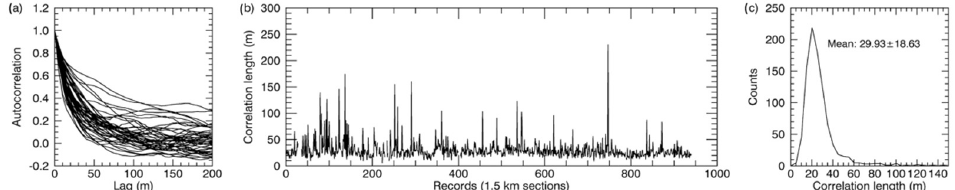
Figure 9. An example of autocorrelation and correlation length of 8 April 2018. All data here are over FYI. ( a ) Examples of autocorrelation vs. lag along the profiles (one for every 20 1.5 km sections is plotted). ( b ) Correlation length for each 1.5 km section. ( c ) Histogram of correlation length. The mean correlation length for the day is 29.93 ± 18.63 m.